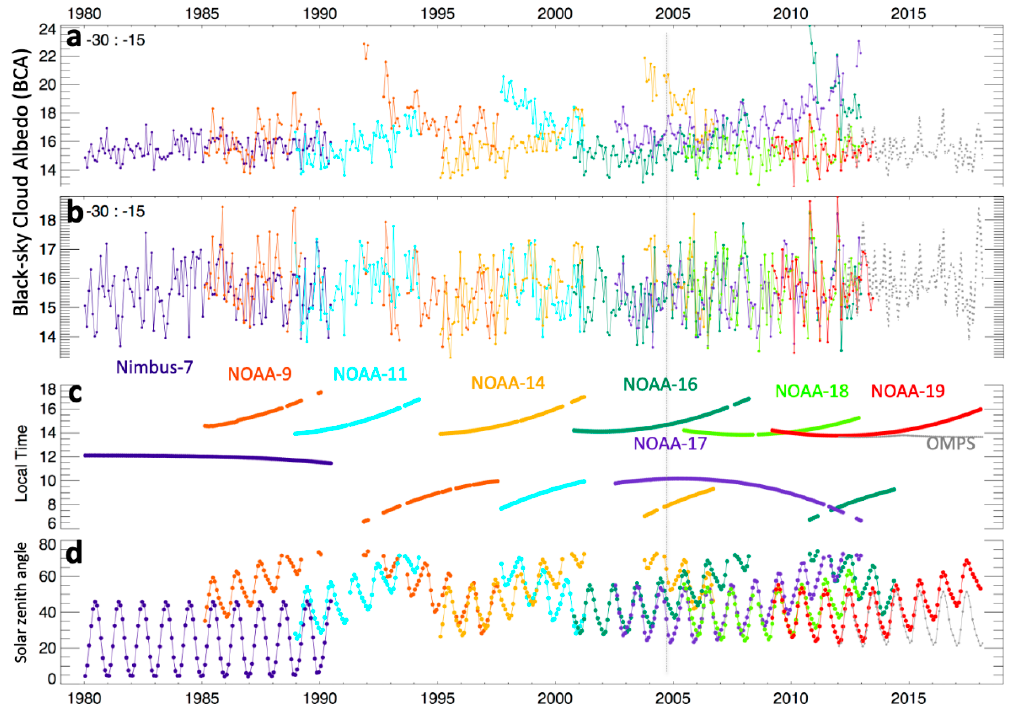
Figure 1. Monthly mean values of black-sky cloud albedo (BCA) (%) over ocean from individual solar backscatter UV (SBUV) instruments (colored traces) and the Ozone Mapping Profiler Suite (OMPS) mapper (gray dotted traces) for the 30°S to 15°S latitude band. ( a ) Un-adjusted BCA, ( b ) diurnally adjusted BCA, ( c ) local time, and ( d ) solar zenith angle.